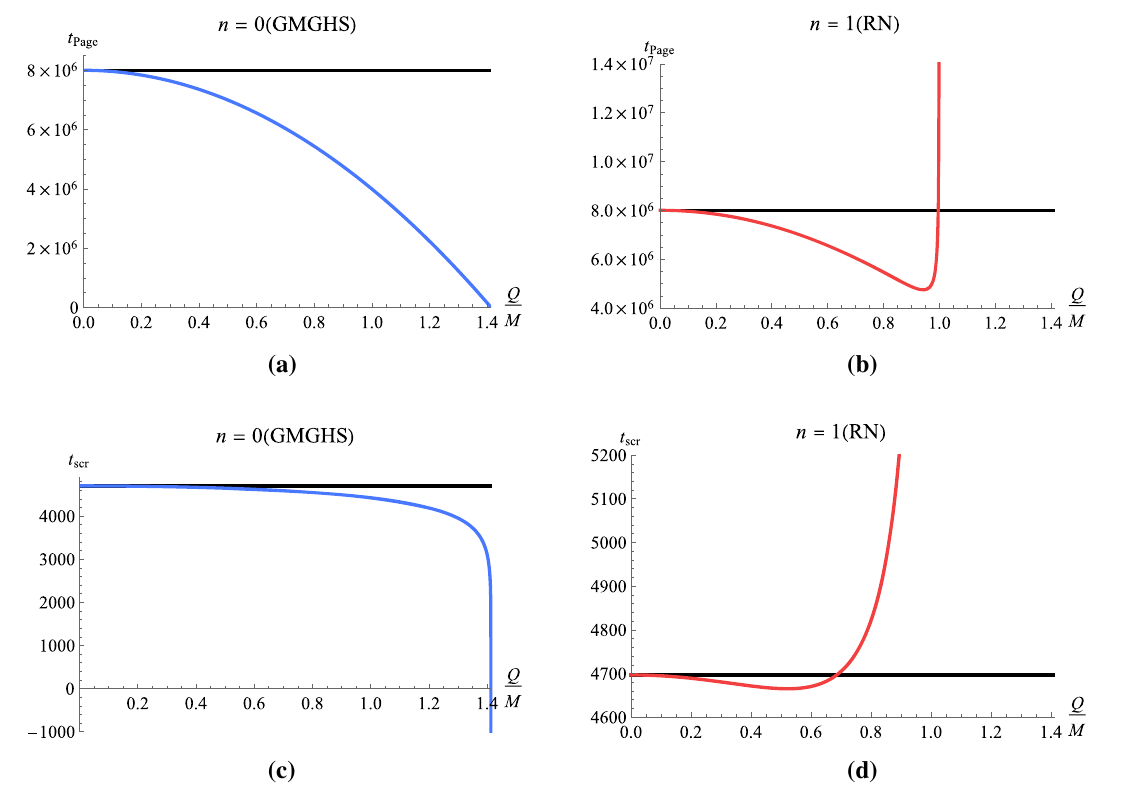
Fig. 7 The Page time and the scrambling time by GMGHS and RN black holes as a function of the charge Q . Black lines represents the results of Schwarzschild black